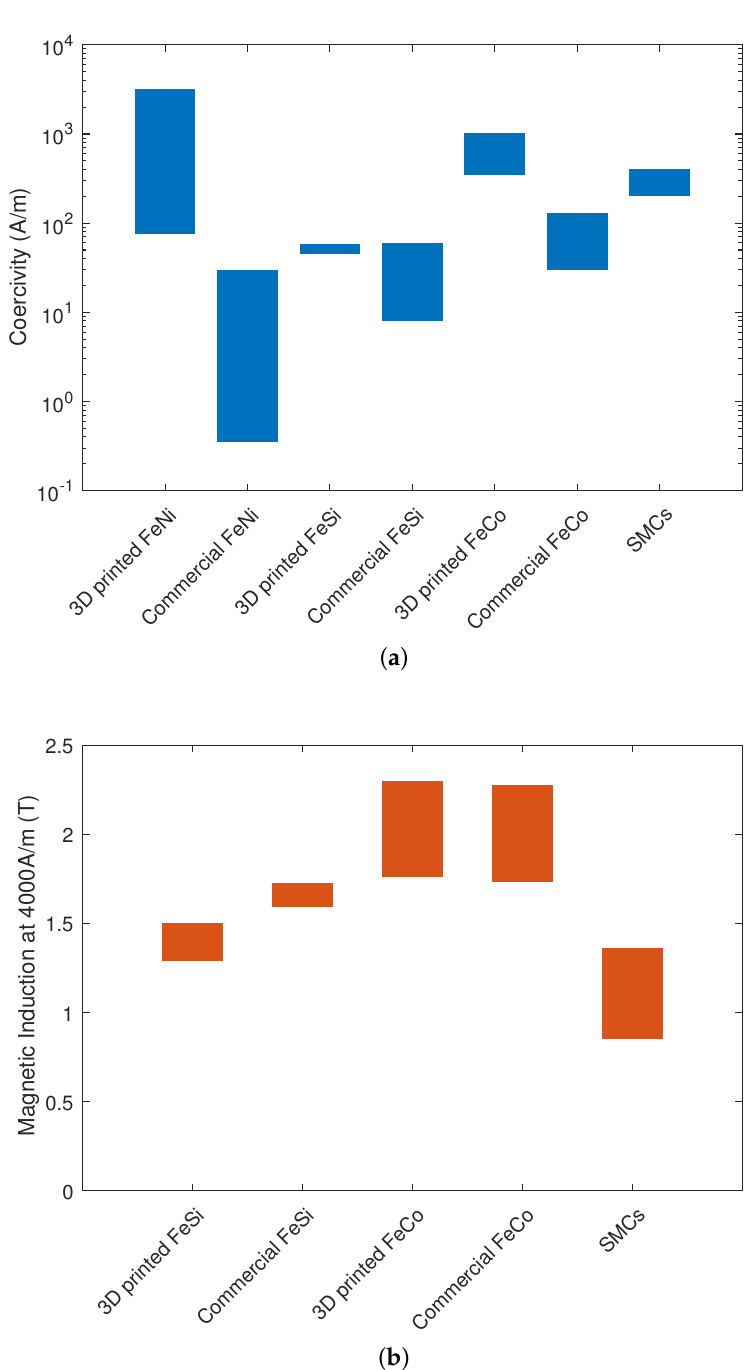
Figure 3. Comparison between additively manufactured and commercial electrical steel. ( a ) Comparison between reported coercivity of 3D printed electrical steels, commercial electrical steels, and SMCs; ( b ) Comparison between reported magnetic induction at 4 kA/m, B 40 , of 3D printed electrical steels, commercial electrical steels, and